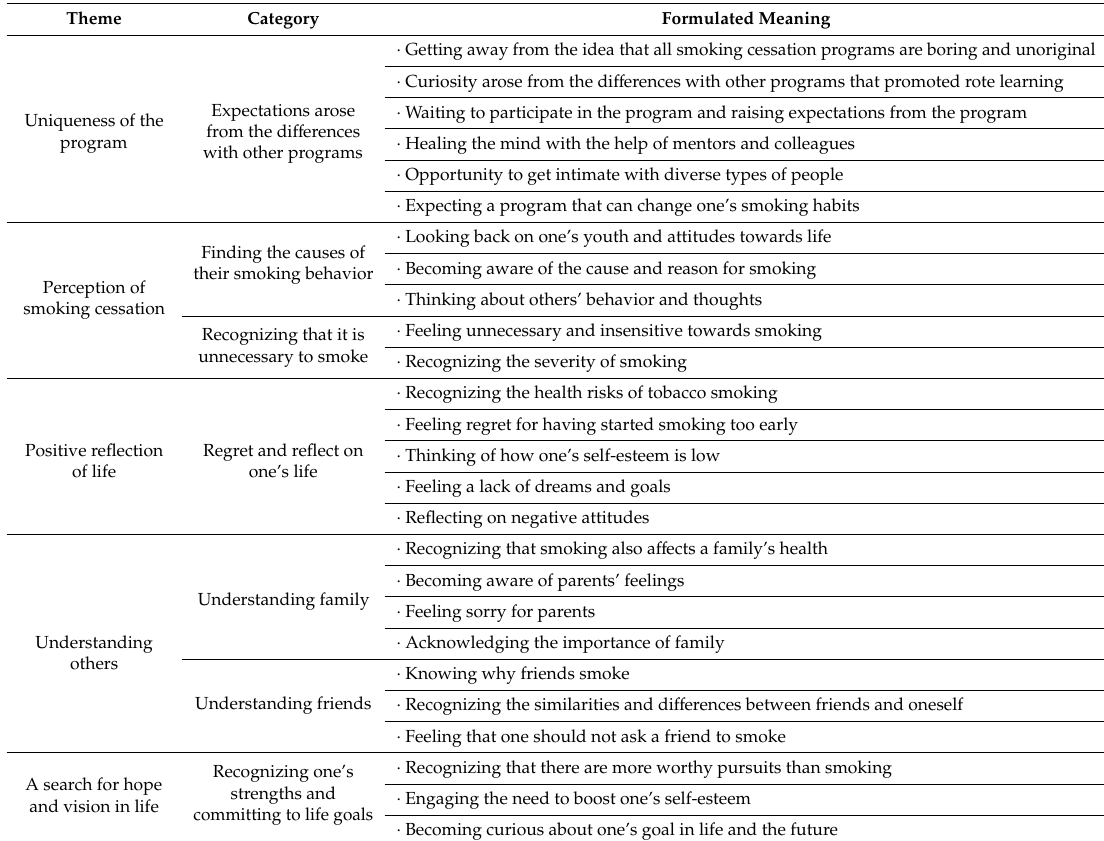
Table 6. Analysis of experiences of the Smoking Cessation